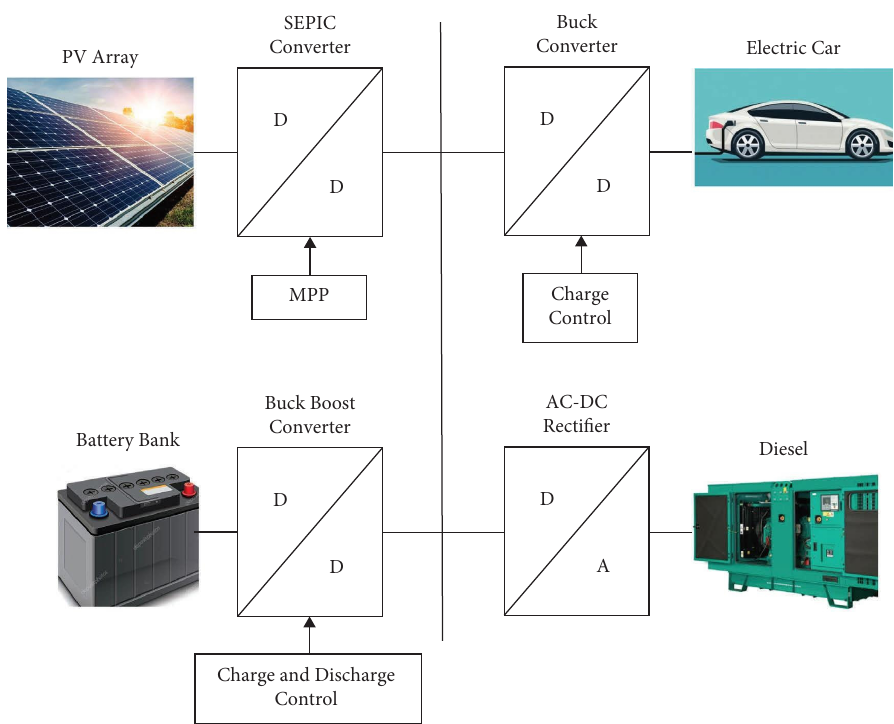
Figure 1: Of-grid charging station for